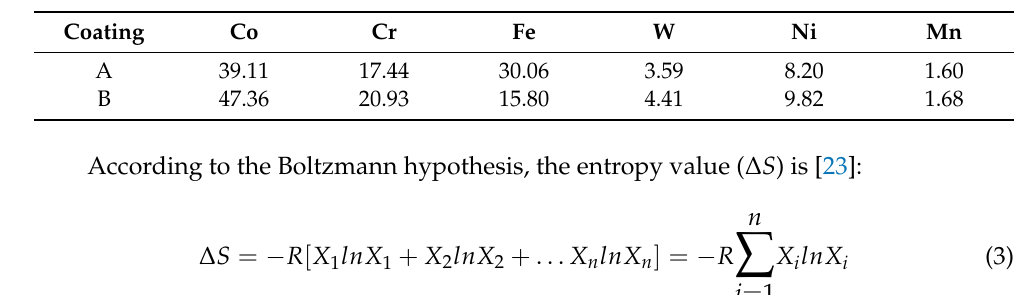
Table 3. Analysis results of the chemical composition on the surface of coatings A and B (mole fraction,